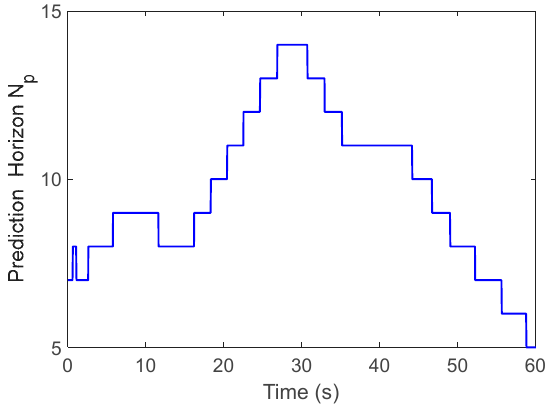
Figure 8. Adjustment of the prediction horizon.